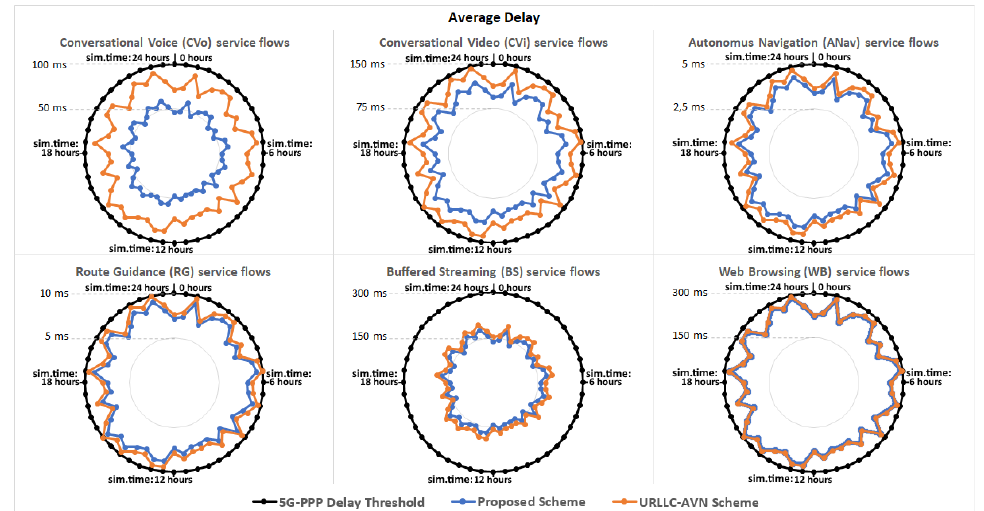
Figure 6. The average delay observed for each service type.